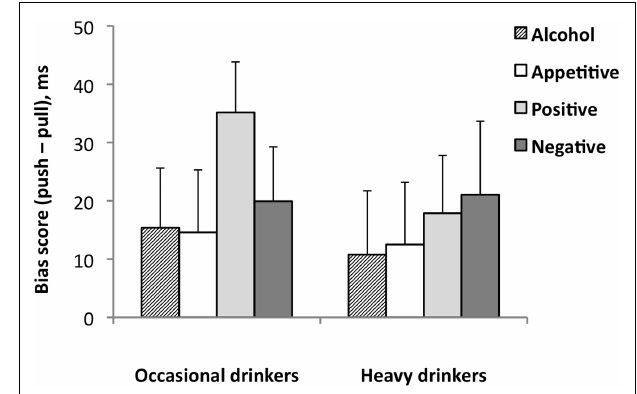
FIGURE 3 | Emotional prime approach avoidance task bias-scores for alcohol, appetitive, positive, and negative pictures in heavy drinkers ( n = 65) and occasional drinkers ( n = 50) . Mean bias-scores are shown with standard error